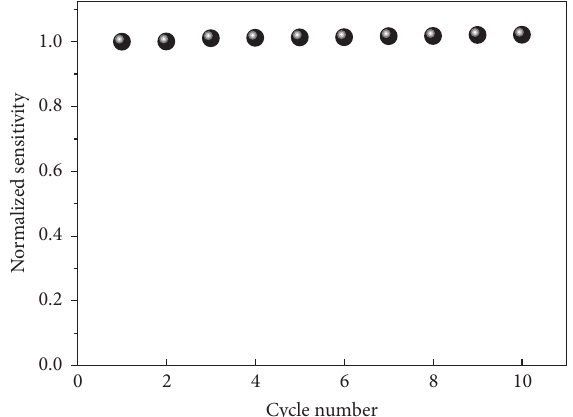
Figure 4: Normalized sensitivity as a function of the irradiation-TL readout cycle number.